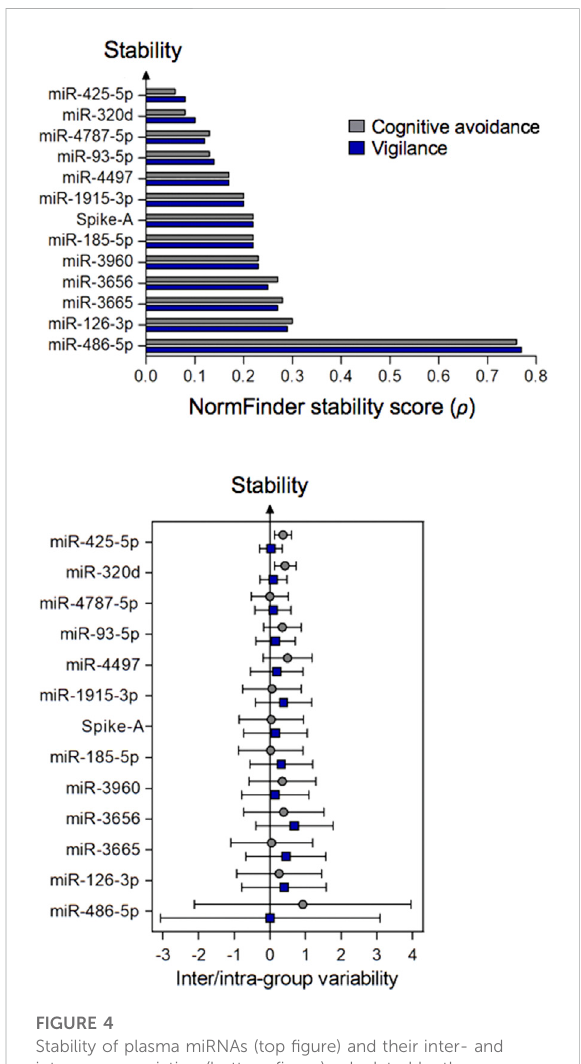
FIGURE 4 Stability of plasma miRNAs (top fi gure) and their inter- and intra-group variation (bottom fi gure) calculated by the NormFinder algorithm. Samples were grouped according to the stress-coping dimensions of cognitive avoidance or vigilance. The circles or squares of the bottom fi gure relate to inter- or intra-group analysis, respectively. Error bars re fl ect the extent of variability. Minimal intergroup variation (close to zero) and small error bars are indicative for a stable miRNA. miRNAs are ranked in descending order based on the stability scores of